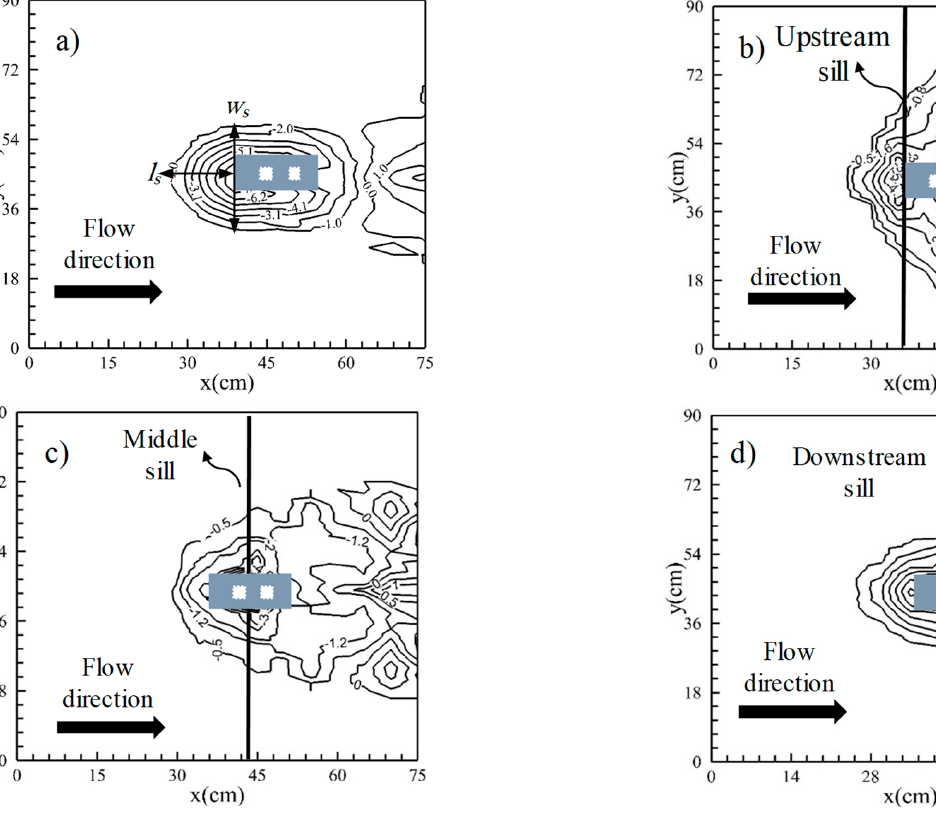
Figure 10. The topography of the final scour bed for Z / D = 1, T pc / D = 1.42, d p / D = 0.85 and pile arrangement of 2 × 3, ( a ) no sill, ( b ) upstream sill, ( c ) middle sill and ( d ) downstream sill. Note that the units of contours are cm.